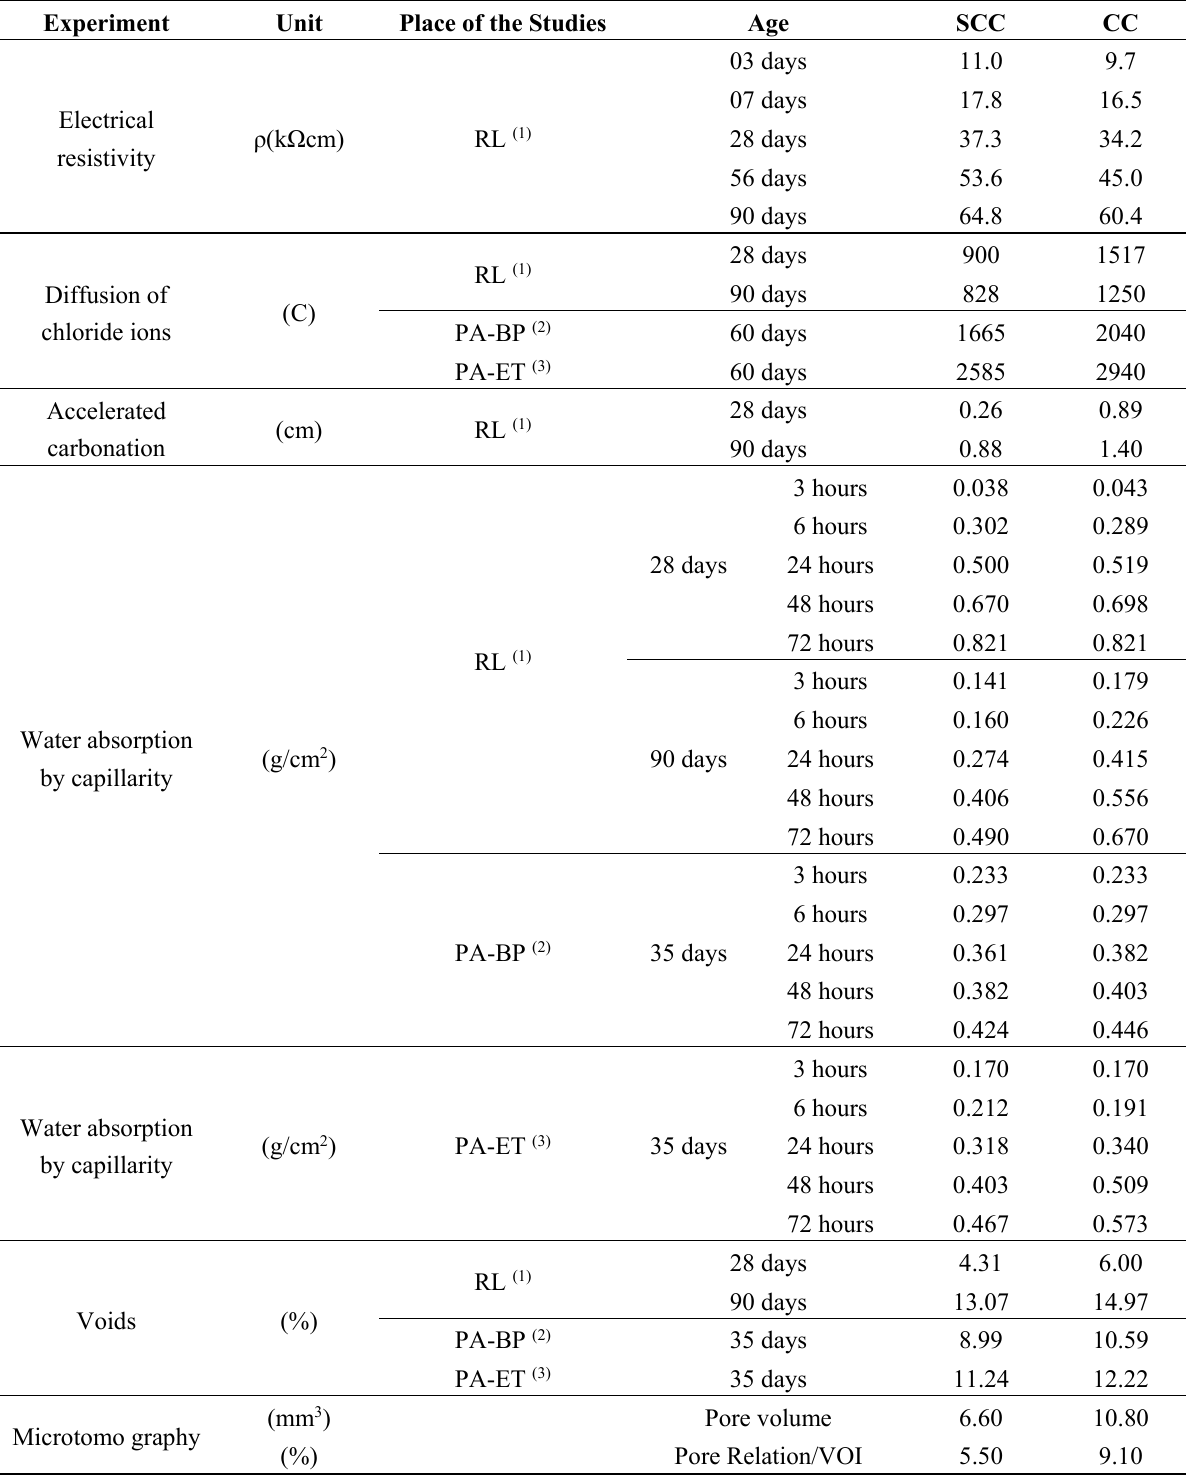
Table 6. Summary of results of durability